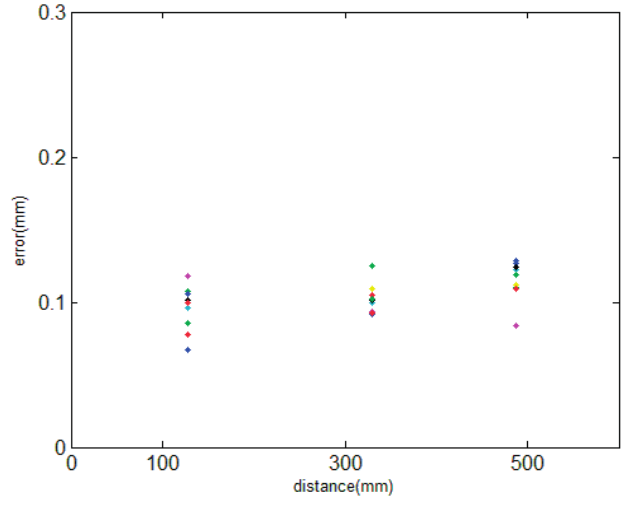
Figure 6. The length of AB, AC and AD measured only by